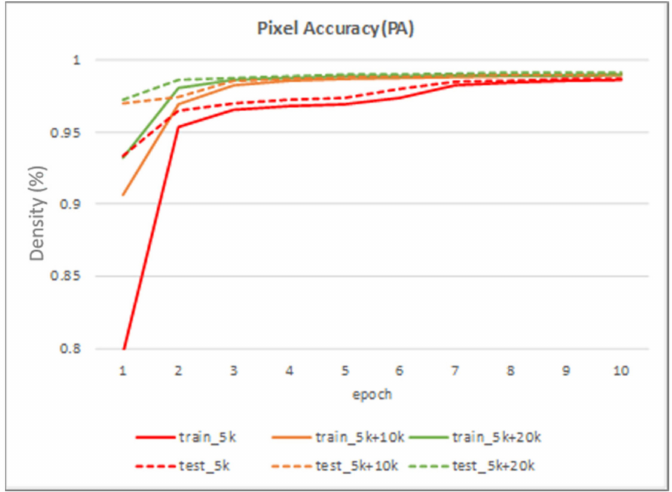
Figure 9. The pixel accuracy curve on training data and testing